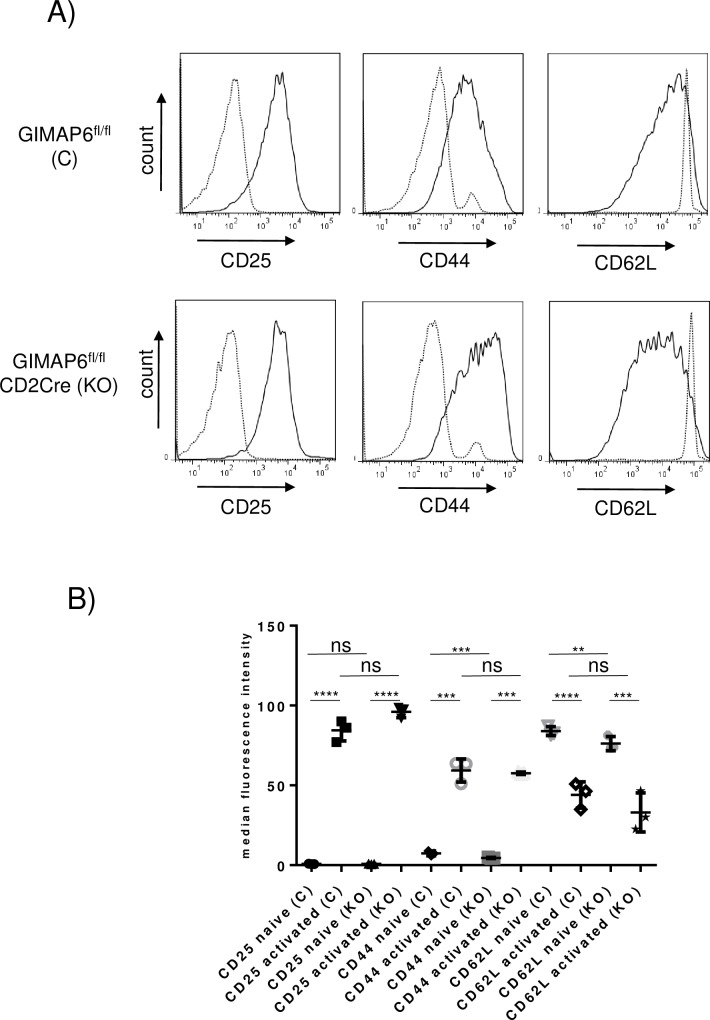
Activation of CD4+ splenocytes from GIMAP6fl/flCD2Cre mice is comparable with those from GIMAP6fl/fl mice.A) CD4+ enriched naïve splenocytes from GIMAP6fl/fl and GIMAP6fl/flCD2Cre mice were activated by maintenance on anti-CD3 antibody-coated plates in medium containing anti-CD28 and IL2 or were maintained in medium without activation. After 72h, cells were stained to measure expression of CD25, CD62L and CD44 to assess the degree of activation. On the histograms dotted lines indicate naïve cells and solid lines, activated cells. B) The median fluorescence intensities of the individual stains from three mice in each group is presented graphically. Unpaired 2-tailed Student’s t-test P values ns p>0.05 ***p<0.001; ****p<0.0001. The experiment was performed twice.